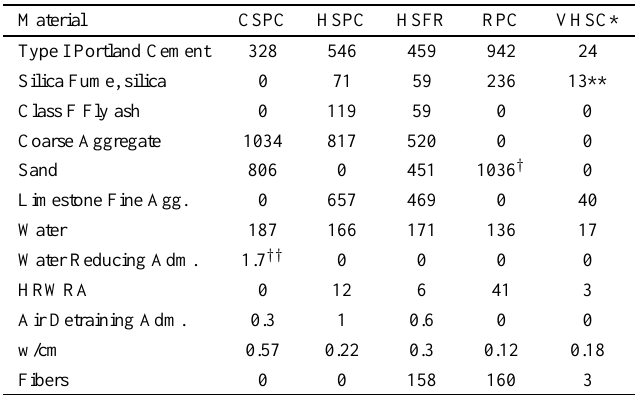
Concrete mixture proportions (kg/m 3